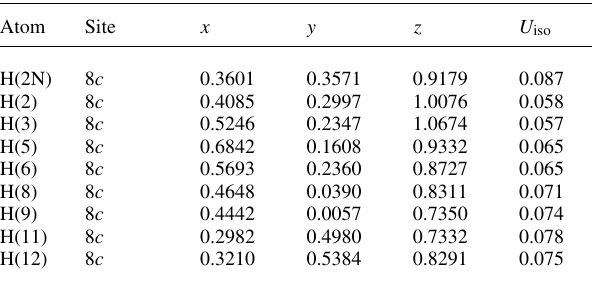
Table 2. Atomic coordinates and displacement parameters (in Å 2 )